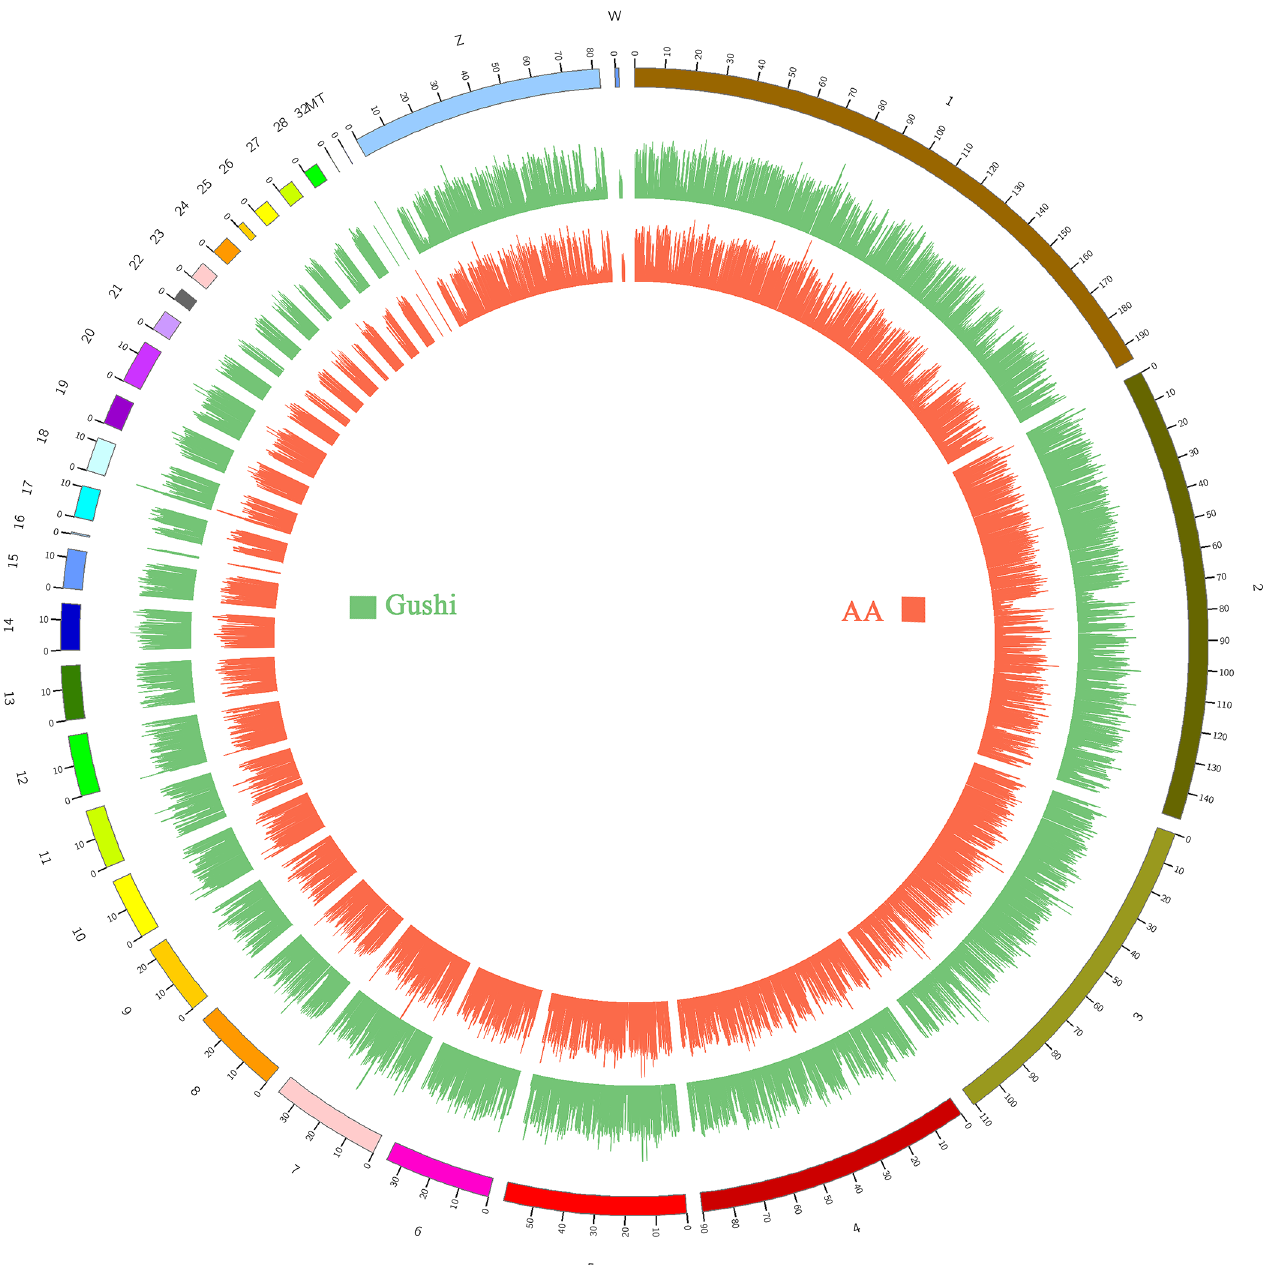
Fig 1. Genome coverage map. The outermostcircle is the genome,the first inner circle shows the chromosomecoverageof the AA chicken (AA), and the second shows that of the Gushi chicken (Gushi). The number on the outer circle representsthe chromosome number, the numberon the inner circle represents the positionon the chromosome, and the unit is